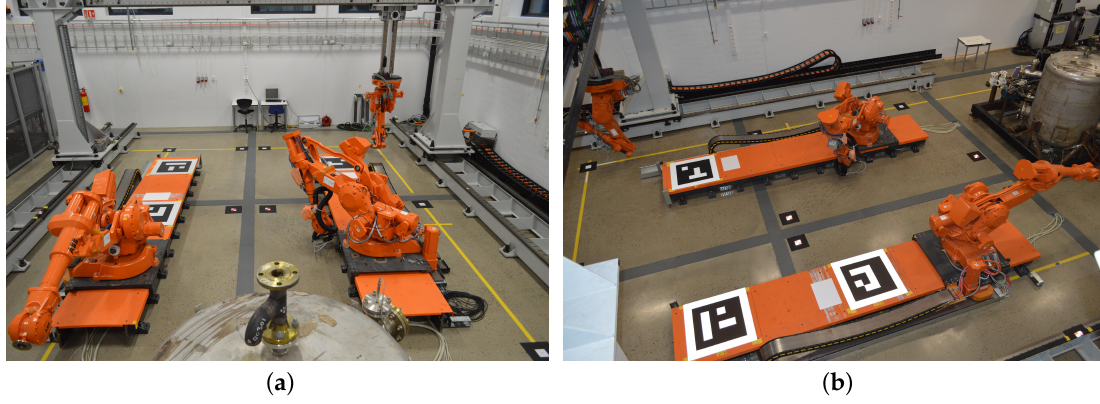
Figure 8. ( a ) overview of the robotic cell which is covered by the embedded sensor nodes; ( b ) the cell seen from a different angle, close to one of the sensor